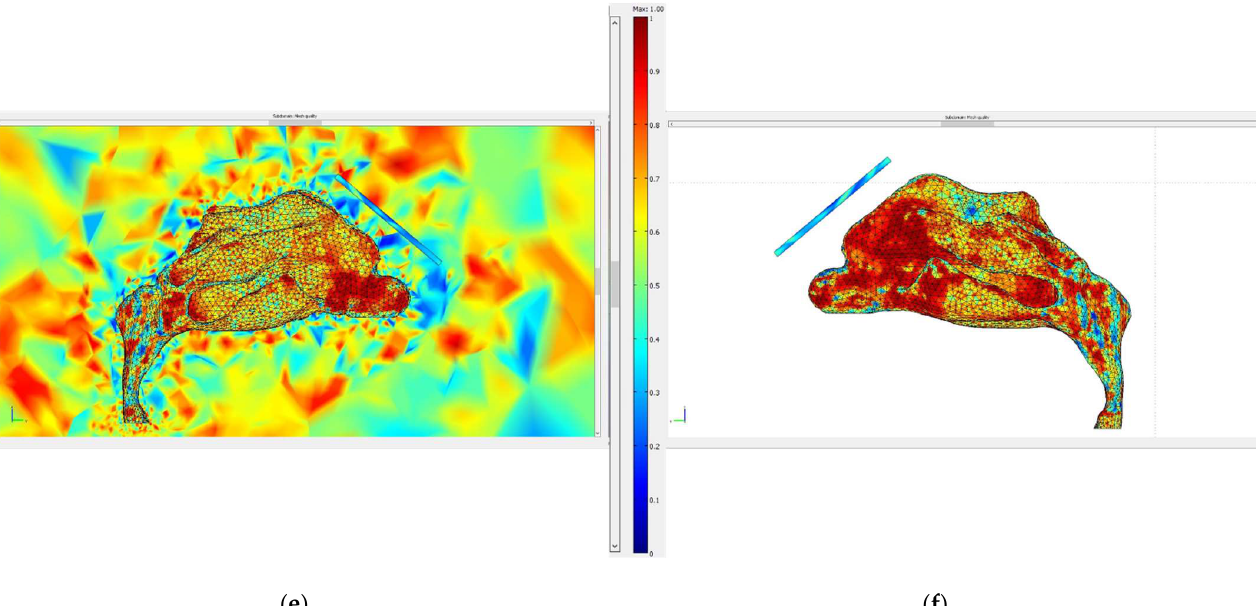
Figure 4. The mesh quality for the protocols in the analysis. ( a , b ) depict the subdomain mesh quality for protocol 1, ( c , d ) the subdomain mesh quality for protocol 2 and ( e , f ) the subdomain mesh quality for Protocol 3. Only the right half of the geometry is illustrated, i.e., the yz plane. The right-side pictures depict the mesh quality only on the domain of the nose and the magnet geometry for visual simplicity. The quality is related to the aspect ratio.